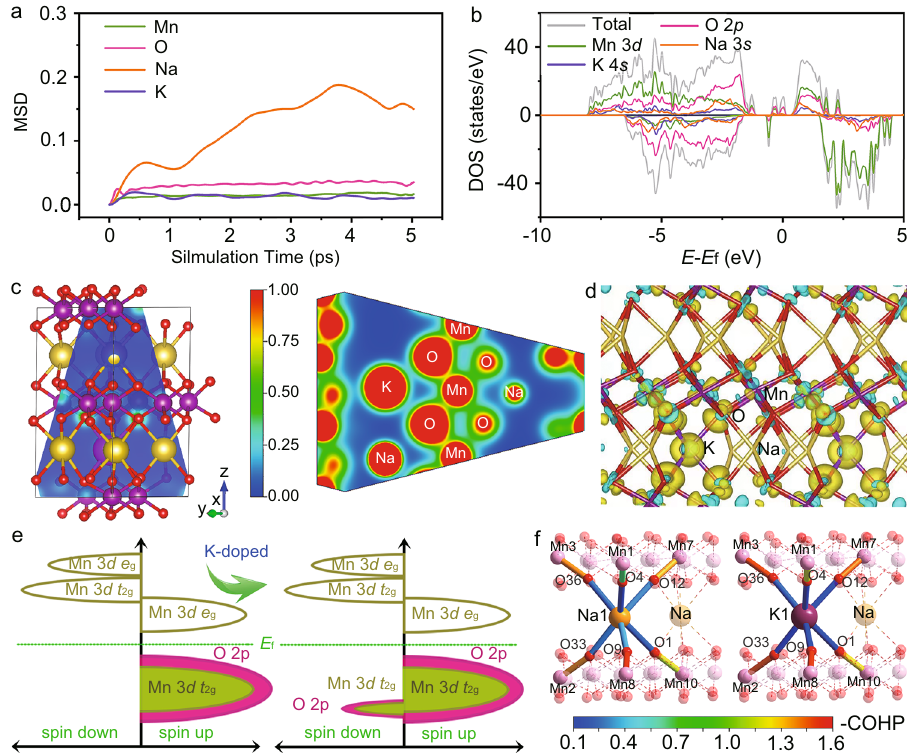
Fig. 5 Simulated atomic and electronic structures. a MSD of Mn, K, Na, and O as functions of time in Na 0.500 K 0.055 MnO 2 . b Total density of states (tDOS) of Na 0.220 K 0.055 MnO 2 and partial density of states (pDOS) of Na 3 s , K 4 s , O 2 p and Mn 3 d orbitals, as labeled by yellow, purple, red and green, respectively. The Fermi energy ( E f ) is set to 0 eV, and the pDOS of Na 3 s , K 4 s are enlarged by 100 times. c Partial charge density distribution along the blue plane in the left panel for Na 0.500 K 0.055 MnO 2 (visualized by Visualization for Electronic and Structure Analysis (VESTA)). The red regions represent high charge density, and the blue regions indicate low charge density. d Plot of deformation charge densities of Na 0.500 K 0.055 MnO 2 . The charge accumulation region is rendered in yellow, and the charge depletion is in blue. e Schematic pDOS of Na 0.555 MnO 2 and Na 0.500 K 0.055 MnO 2 . f COHP analysis on representative prismatic sites and the adjacent MnO 6 -octahedra sites of Na 0.555 MnO 2 and Na 0.500 K 0.055 MnO 2 cannot be applicable to the two-phase regions, CVs at different scan rates are used to calculate the apparent values of D Na + in